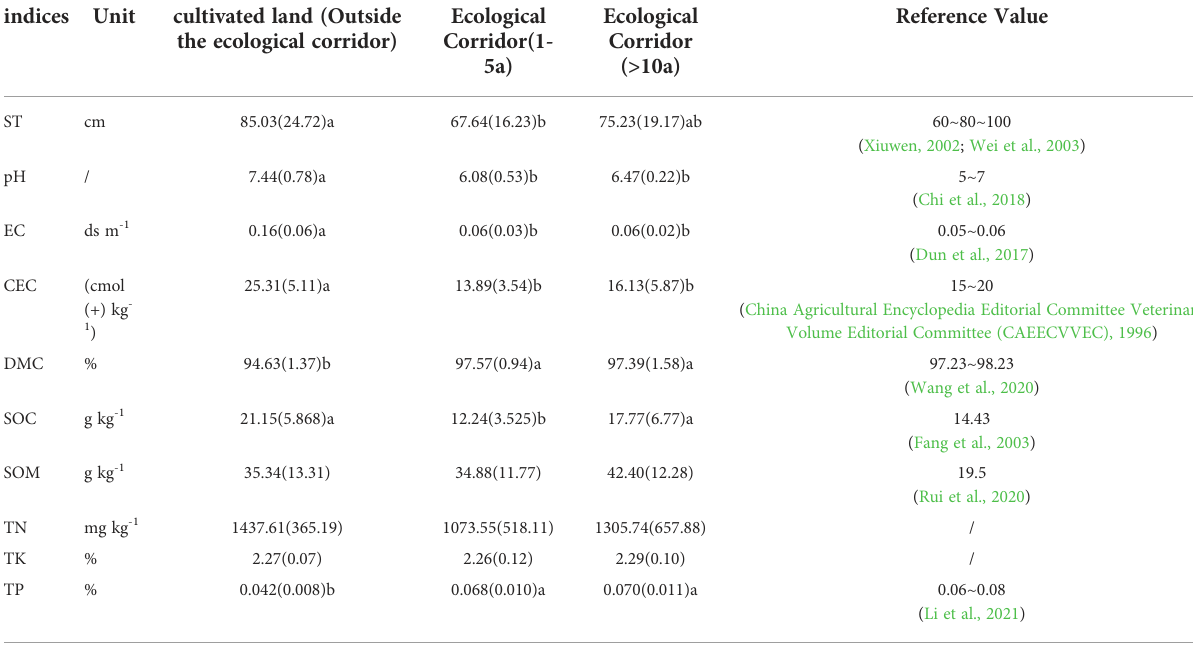
TABLE 4 Mollisols and site properties for the ecological corridor, cultivated land, standard deviation in brackets. indices